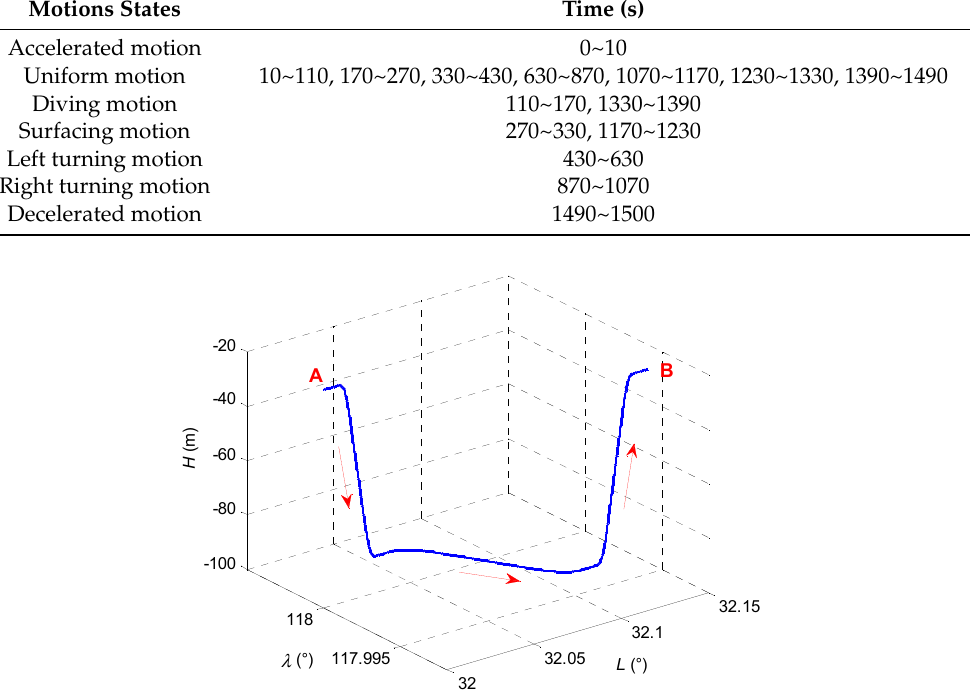
Figure 6. The sailing trajectory of the underwater vehicle.